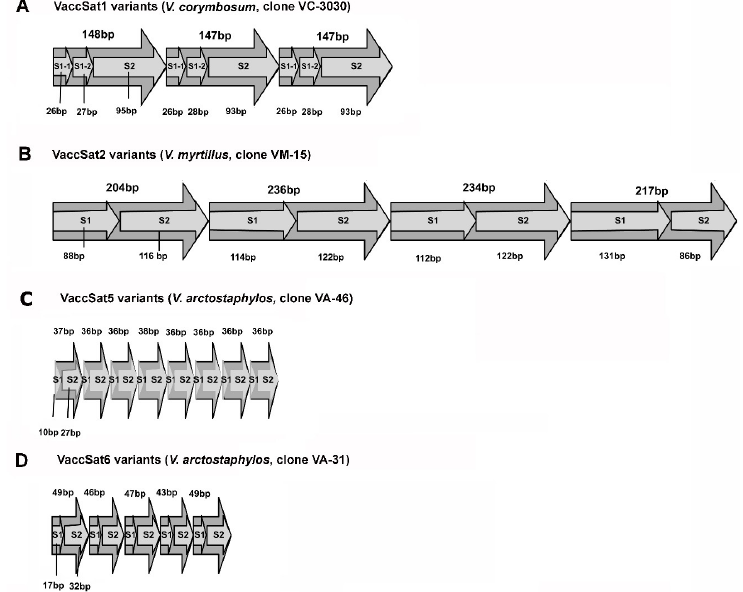
Figure 2. Higher order repeat (HOR) structure of Vaccinium satellite repeats. HOR patterns from the longest multimeric clones of di ff erent Vaccinium species have been selected as representative examples. ( A ) Structure of VaccSat1 from V. corymbosum , clone VC-3030; ( B ) structure of VaccSat2 from V. myrtillus , clone VM-15; ( C ) structure of VaccSat5 from V. arctostaphylos (elongated fruit), clone VA-46; ( D ) structure of VaccSat6 V. arctostaphylos (elongated fruit), clone VA-31. Length (bp) of each individual monomer sequences are shown above each monomer sequence. S1 = Subunit1, S1-1 =